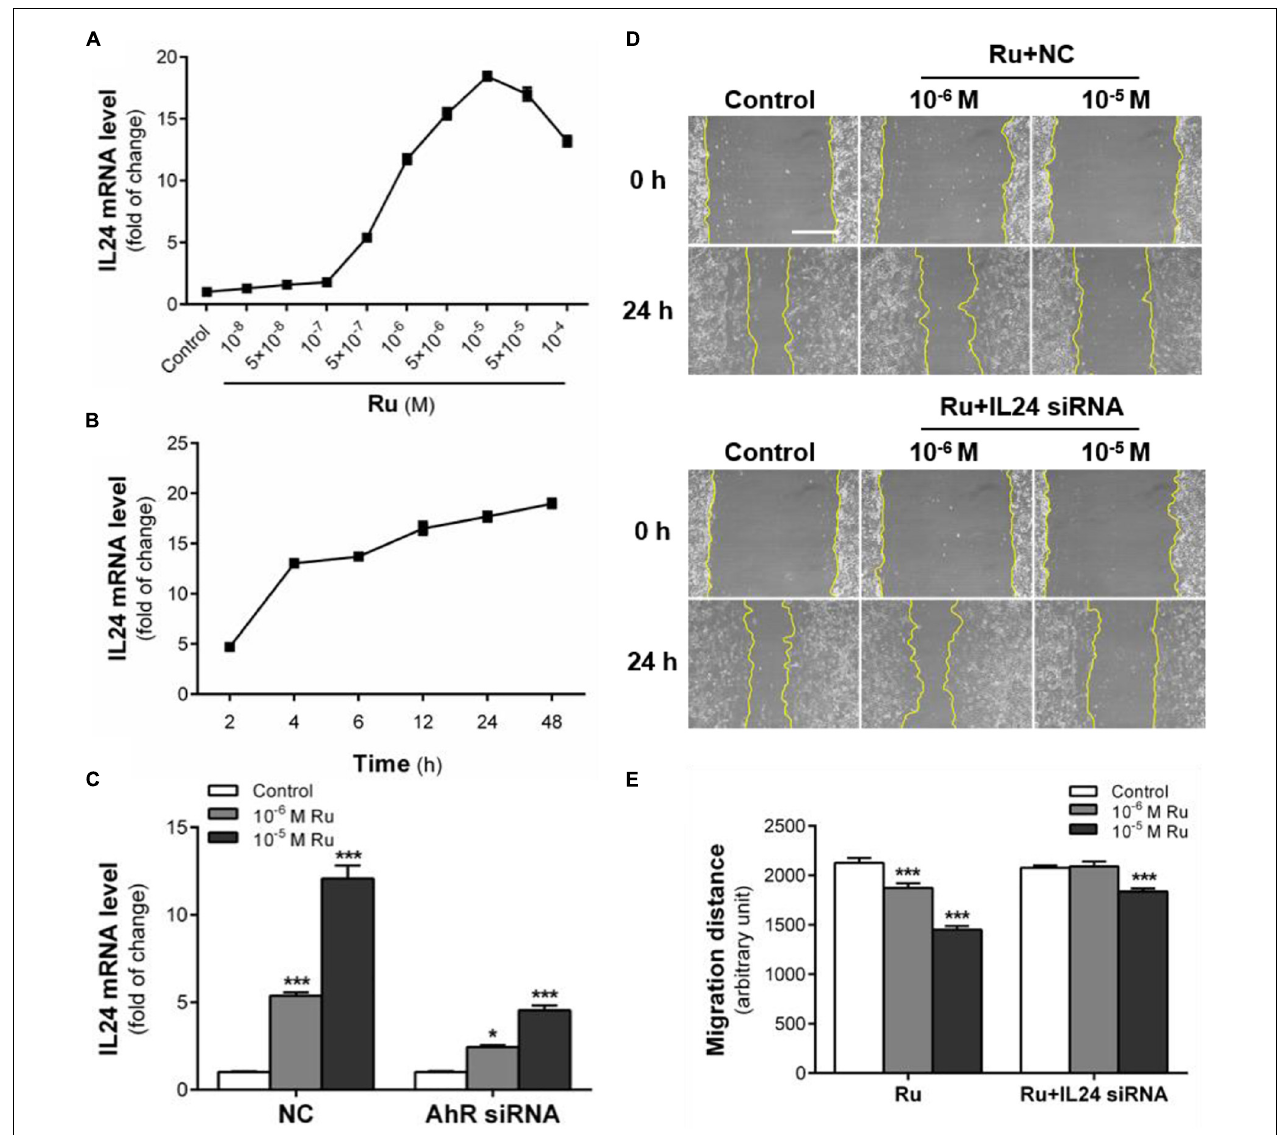
FIGURE 7 | IL 24 mediates the inhibitory effect of rutaecarpine on migration. (A) Dose relationship between rutaecarpine with IL24 expression after 48 h treatment with 10 − 8 –10 − 4 M rutaecarpine or 0.1% DMSO. (B) Time relationship of rutaecarpine with IL24 expression after 2, 4, 6, 12, 24, 48 h treatment with 10 − 4 M rutaecarpine. (C) Effect of rutaecarpine 48 h treatment on IL24 expression before and after AhR knockdown. The mRNA expression of IL24 in U87 cells was determined by qPCR analysis. A wound healing assay was used to analyze the effect of IL24 on U87 cells migration. IL24 mRNA interference was treated as indicated. (D) Typical images of wound healing assay were taken at 0 and 24 h about different treatment groups. Scale bar = 0.5 mm. (E) Quantitative data graph of wound healing assay. After 24 h treatment with 10 − 6 and 10 − 5 M rutaecarpine or 0.1% DMSO, the distance of migration was counted. * p < 0.05, *** p < 0.001 compared with control group. All values are fold of control that was treated with the solvent and represent the mean ± SEM ( n = 3). SEM, standard error of the mean; Ru,